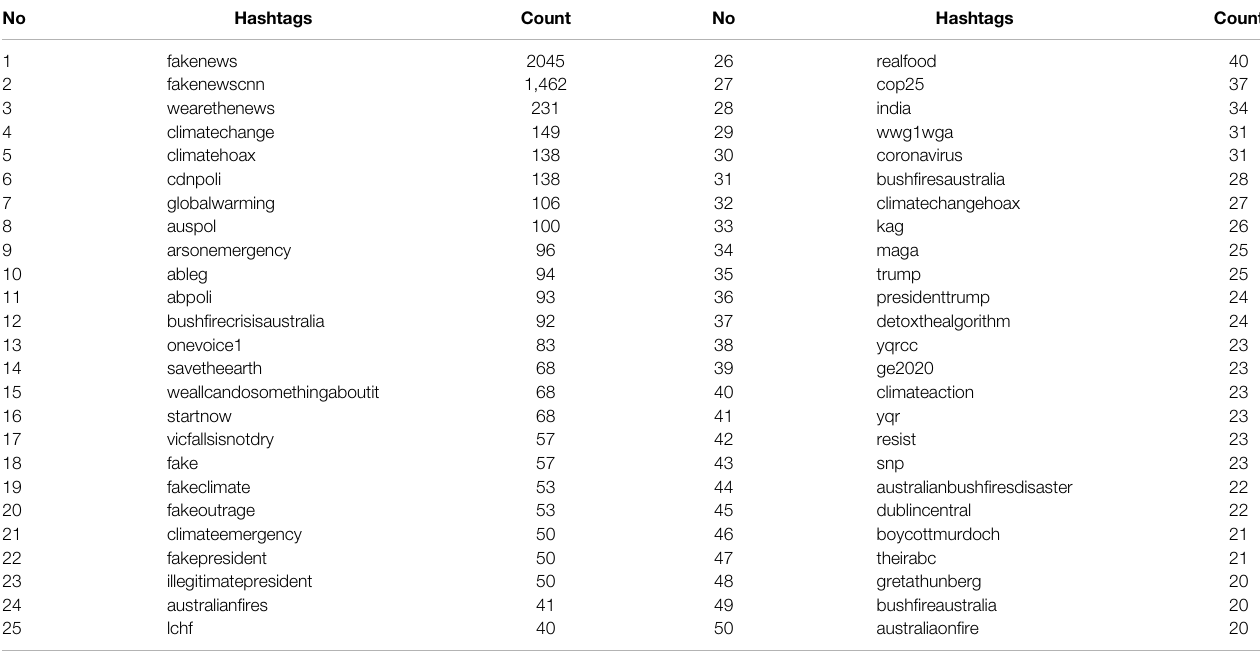
TABLE 2 | The top 50 most mentioned